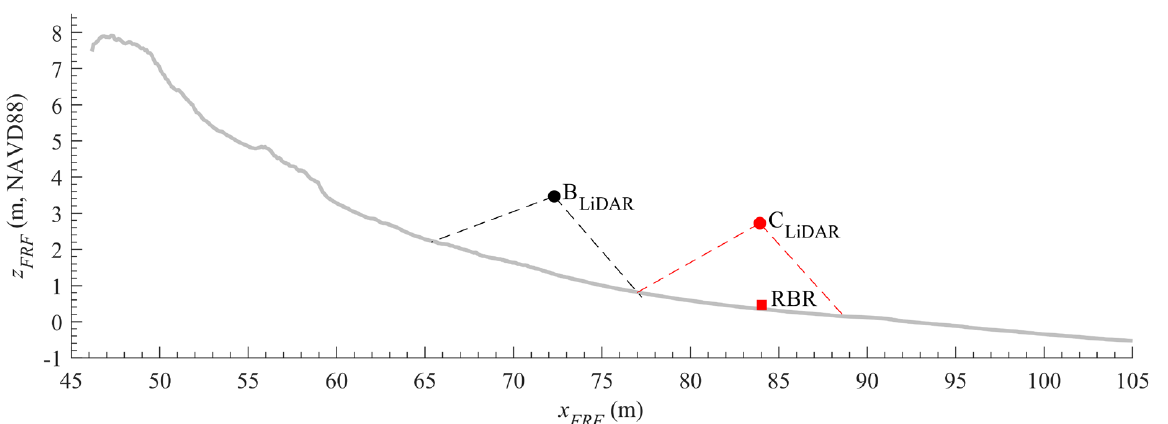
Figure 3. Profile view of the instrument installation locations, in FRF coordinates: LLC LiDAR (solid circles) and RBR solo 3 D |wave16 logger (square). The field of view of each LLC LiDAR is represented with dashed lines. Black (red) denotes Series B (Series C). The time-averaged beach profile measured by the FRF DUNE LiDAR over the deployment duration (16–18 November 2020) is shown for reference (thick gray).